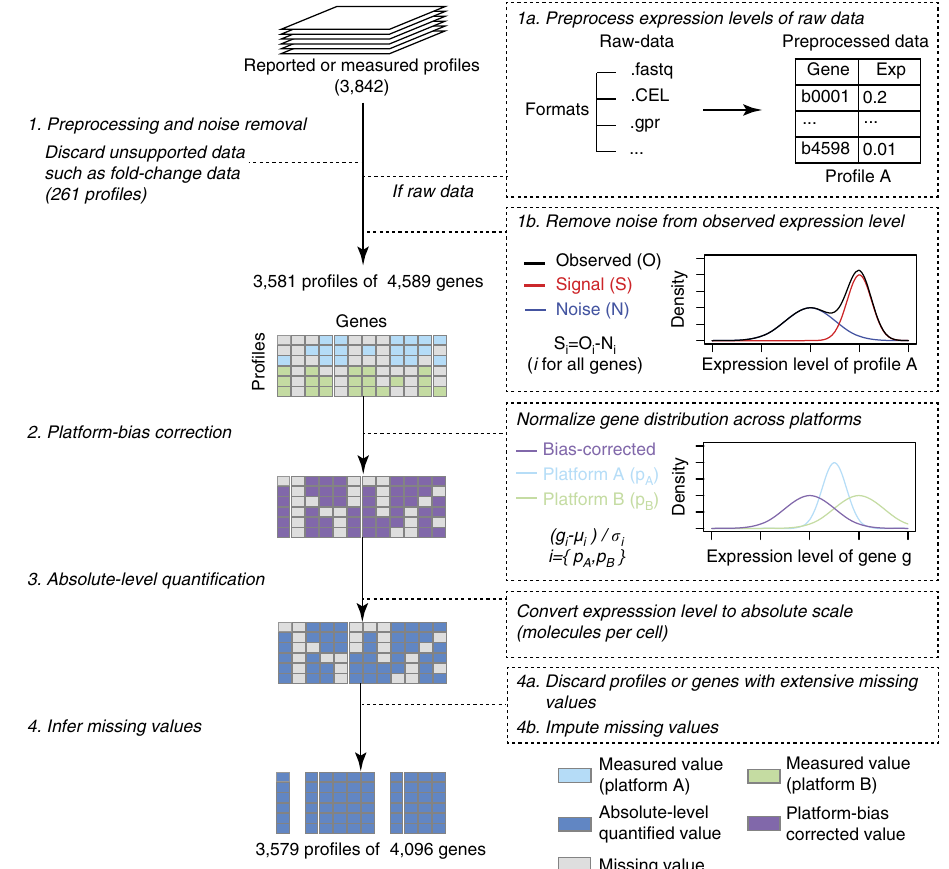
Figure 2 | Overview of Ecomics data processing steps. Raw profiles were first processed to calculate expression levels or molecular concentrations. Noise removal and bias correction normalized data across different platforms. Absolute level quantification converted relative expression level to absolute numbers for cross-condition comparison. Final quality control removed low quality entries and inferred missing